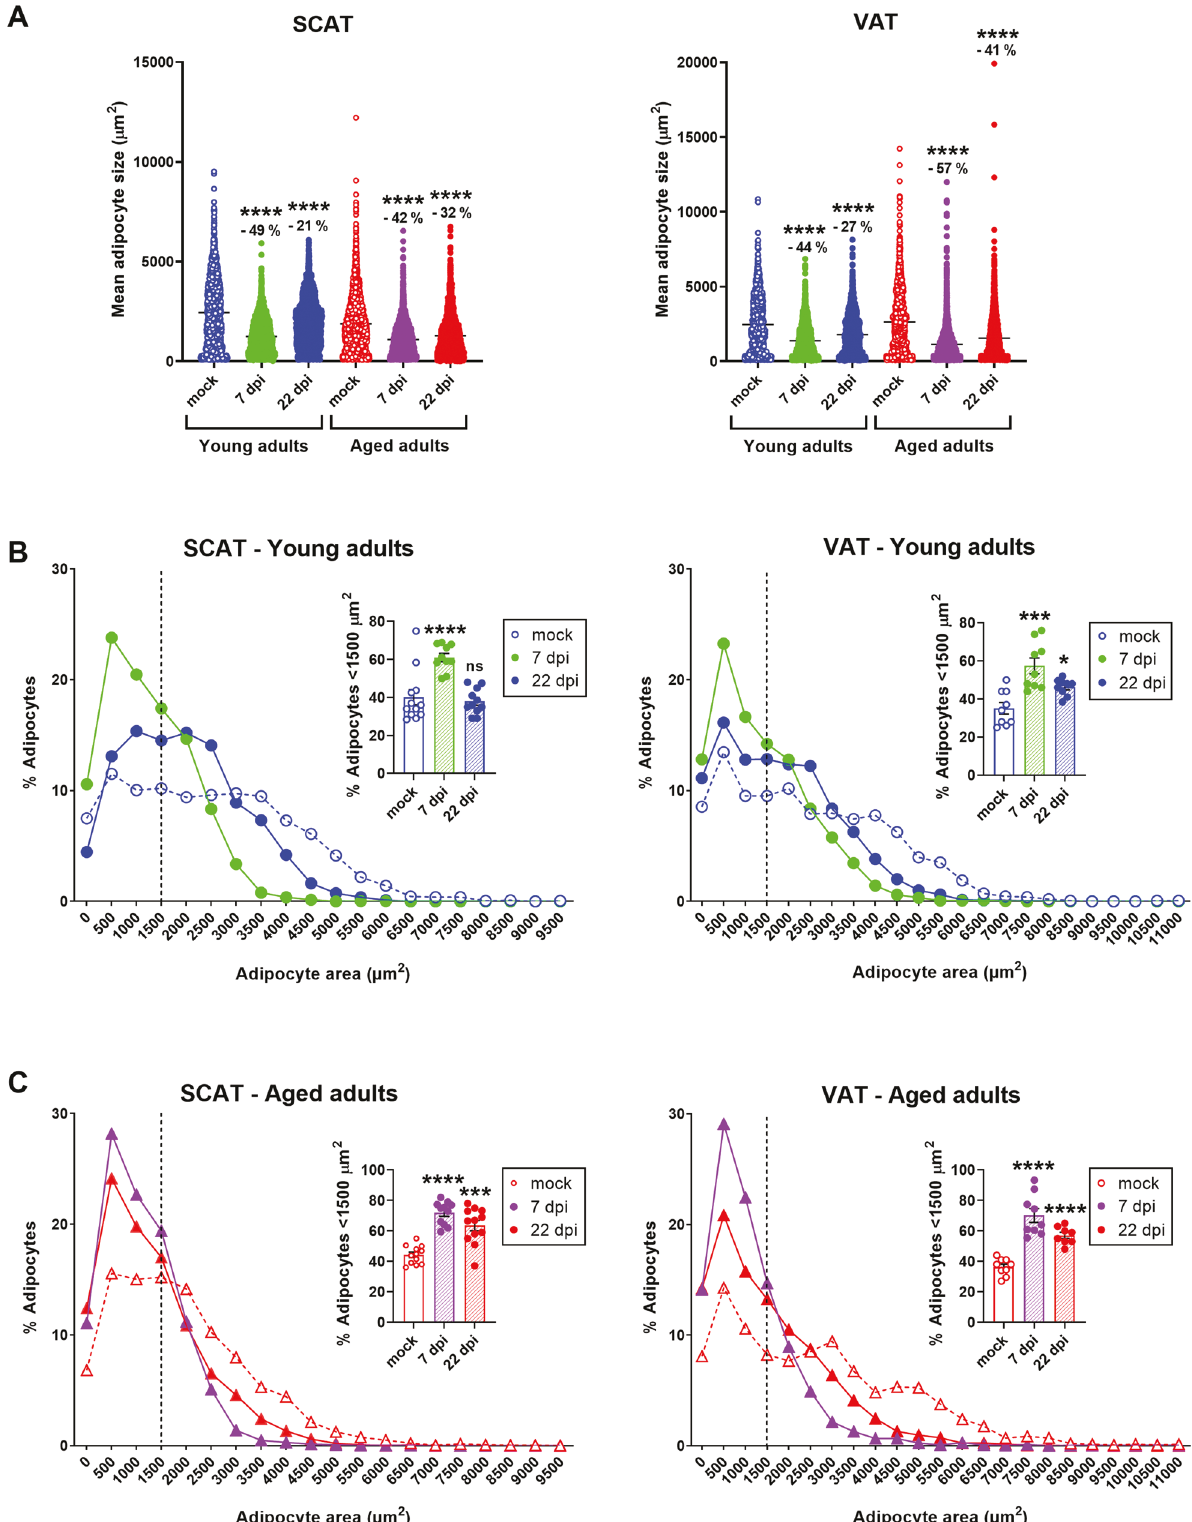
decreased upon SARS-CoV-2 infection in both age groups, and 51 lipid species were speci fi cally decreased in aged hamsters only (Fig. 6C and Table 3). These results show that SARS-CoV-2-infection-induced altera- tions of plasma lipid pro fi les signi fi cantly differ between